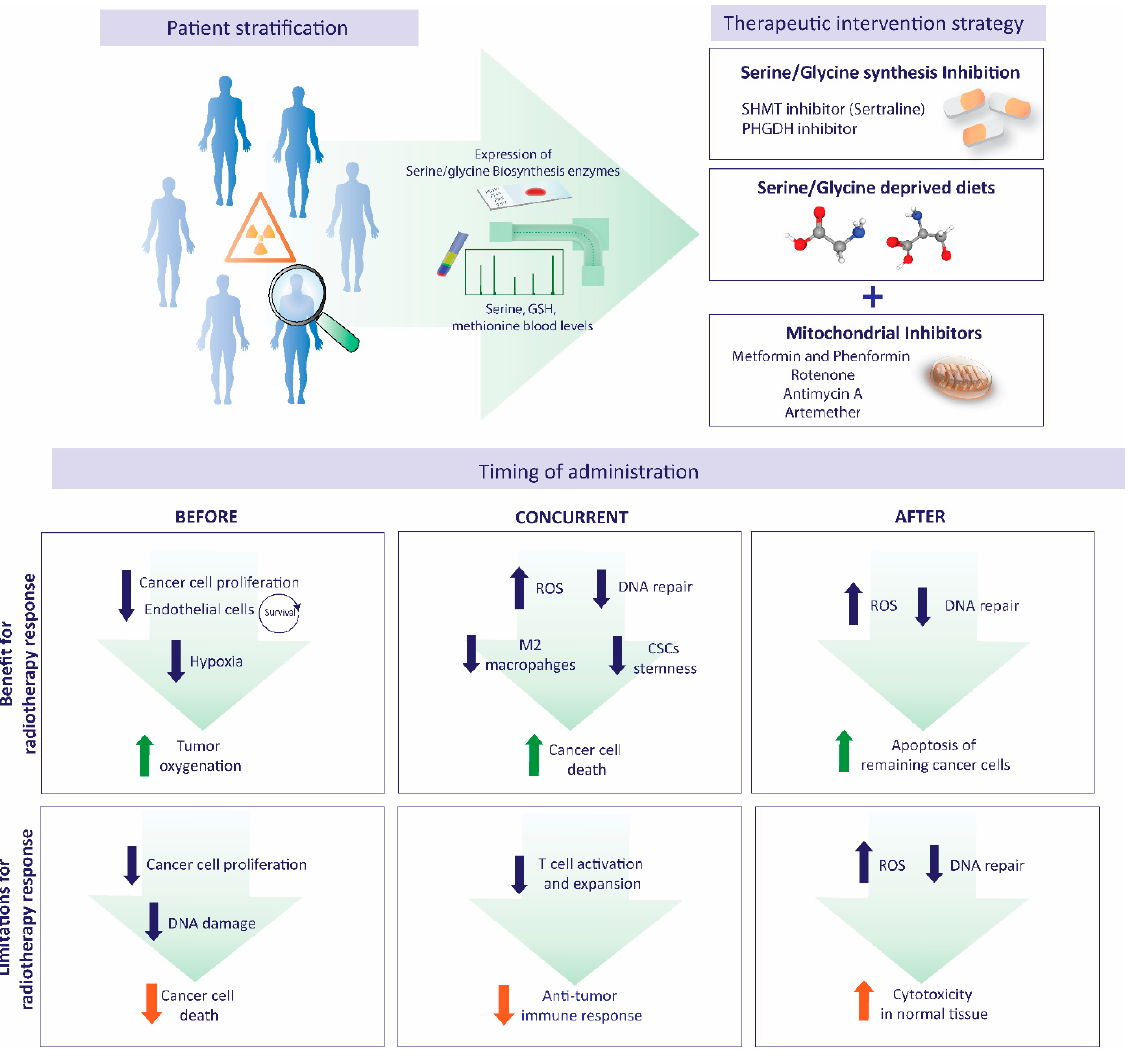
Figure 5. Future perspectives overview implicating serine/glycine metabolism-targeted therapies in combination with radiation therapy. The rational integration of serine/glycine metabolism-targeted therapies in combination with radiother- apy is important to optimize the efficacy and enhance the therapeutic ratio of radiotherapy. The stratification methods to select patients that might benefit from these combined treatment modalities could include the analysis of serine, GSH, or methionine serum levels or the expression of de novo serine/glycine biosynthesis enzymes. The therapeutic strategies targeting serine/glycine metabolism include limiting the availability of exogenous serine by diet restriction and targeting the enzymes of de novo serine/glycine biosynthesis pathways, for instance, SHMT inhibition using sertraline. In addition, mitochondrial inhibitors, e.g., metformin, phenformin or artemether, might have synergistic antitumor effects in combi- nation with serine/glycine-targeted strategies and enhance the response to radiotherapy. Finally, targeting serine/glycine metabolism before radiotherapy, concomitantly or sequentially, requires considering serine/glycine metabolism functions in cancer cells and the tumor microenvironment and how targeting this metabolic pathway might enhance or counteract the response to radiotherapy. The blue arrows indicate expected cellular changes, in green beneficial outcome of the cellular changes and in orange the limitations of the outcomes related to the cellular